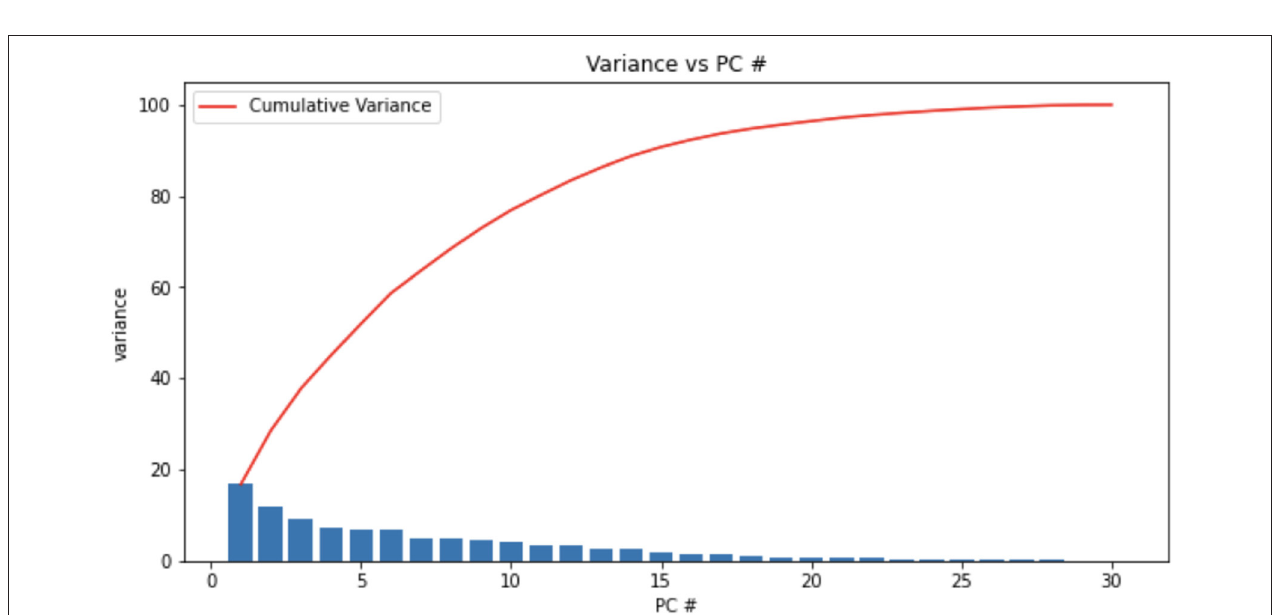
FIGURE 7 | The variance vs. the 30 principal components. The cumulative variance reached a plateau at close to 15 principal components. We found that 23 of the 30 principal components were the most prominent. See text for details.